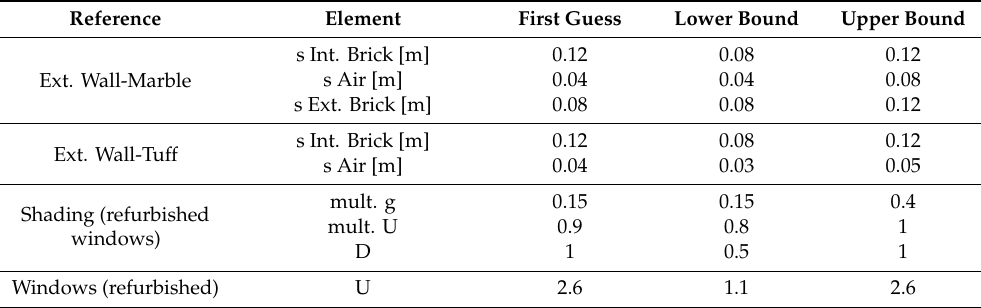
Table 7. Parameters collection for Calibration B *.